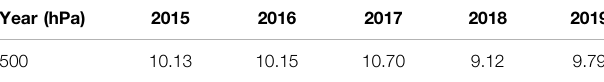
TABLE 1 | The average value of Euclidean distance ( Eq. 1 ) of all meteorological elements of 500 hPa relative to March 2020. The elements include geopotential height, relative humidity, temperature, u component of wind, v component of wind, vertical velocity and relative